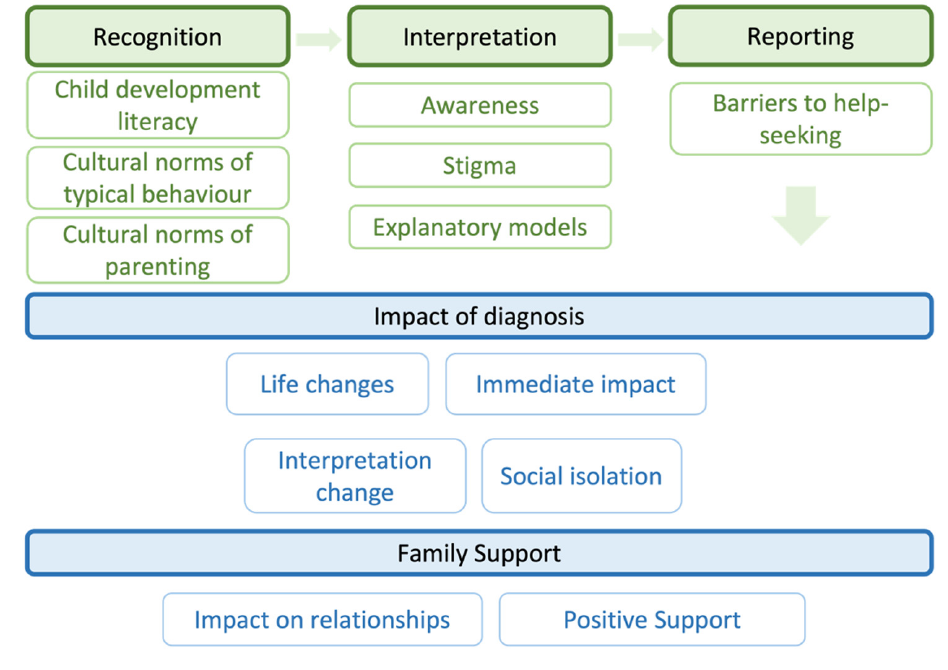
Figure 1. Overall Themes from the analysis .